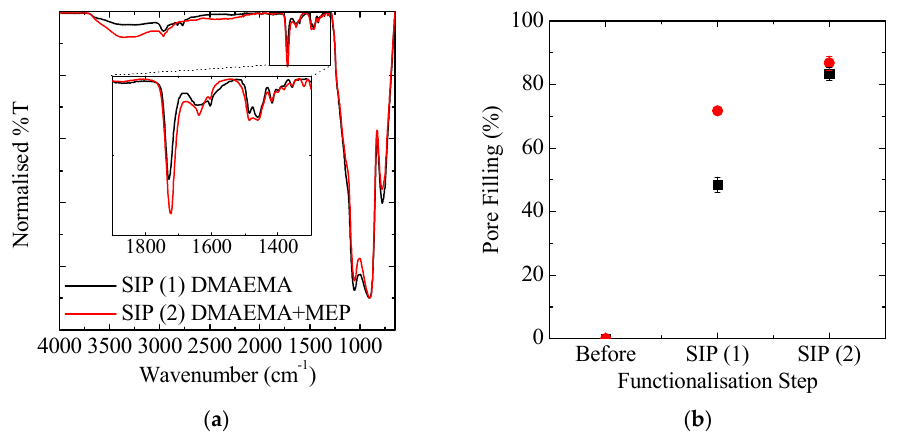
Figure 8. ( a ) IR spectra of mesoporous silica (16 nm pores) after performing a SIP with DMAEMA (SIP (1), black trace) and subsequent chain-extension with MEP (SIP (2), red trace); ( b ) corresponding volume pore filling of mesoporous silica with 8 nm (black squares) and 16 nm (red circles) pores post-grafted with SBDC before and after performing a SIP with DMAEMA (SIP (1)) and chain-extension with MEP (SIP (2)). The non-functionalised 8 and 16 nm mesoporous silica films are characterised by a porosity of 40 and 57%, respectively. Reaction conditions for SIP (1): DMAEMA:DMF = 1:8 ( v / v ), t = 5 min, λ = 365 nm. Reaction conditions for SIP (2): [MEP] = 0.125 M, solvent = water, t = 15 min, λ = 365 nm. The pore filling was estimated assuming the refractive index of the polymer is 1.517 (PDMAEMA) [49].